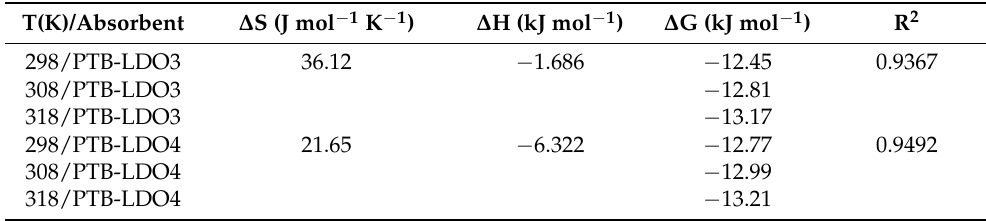
Table 2. Thermodynamic parameters for the adsorption of F − by PTB-LDO3 and PTB-LDO4.